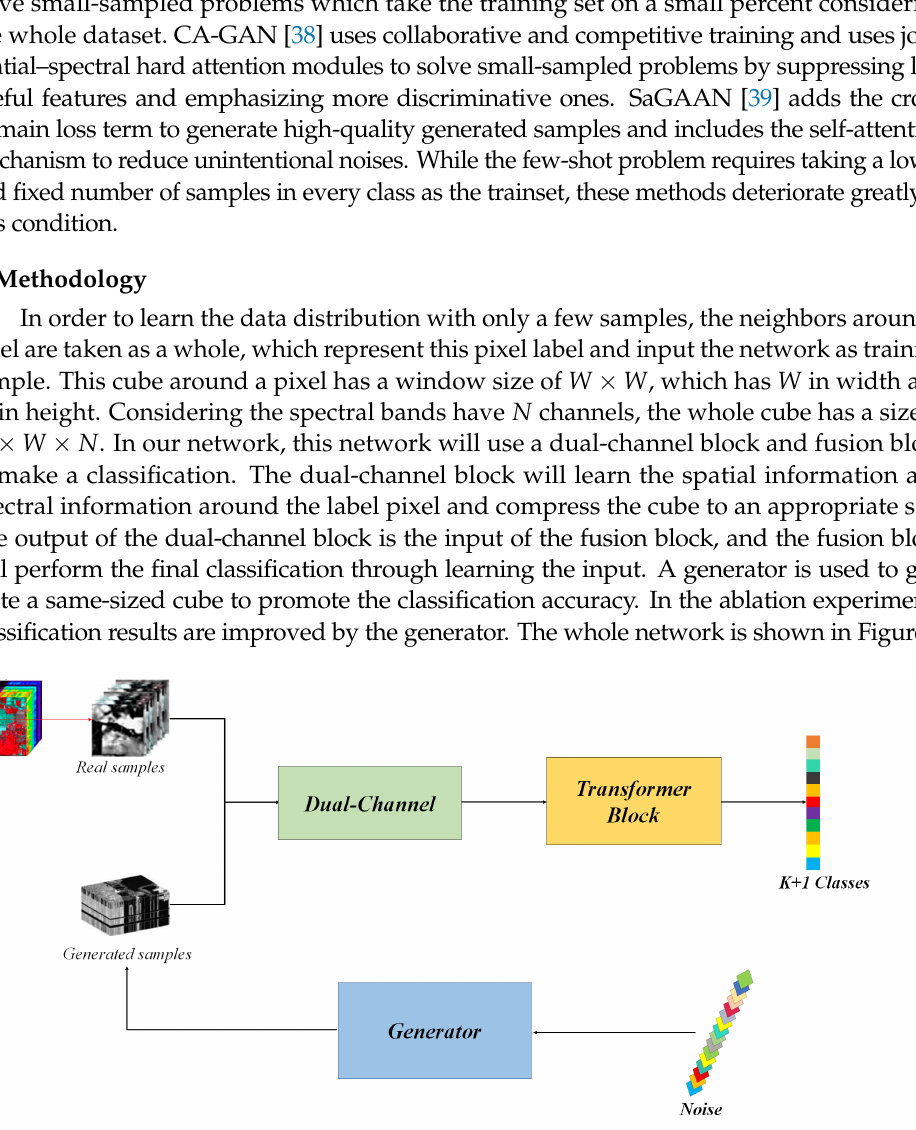
Figure 1. The overall framework of the proposed method for few-shot classification. As can be seen, the framework is a classic Generative Adversarial Network